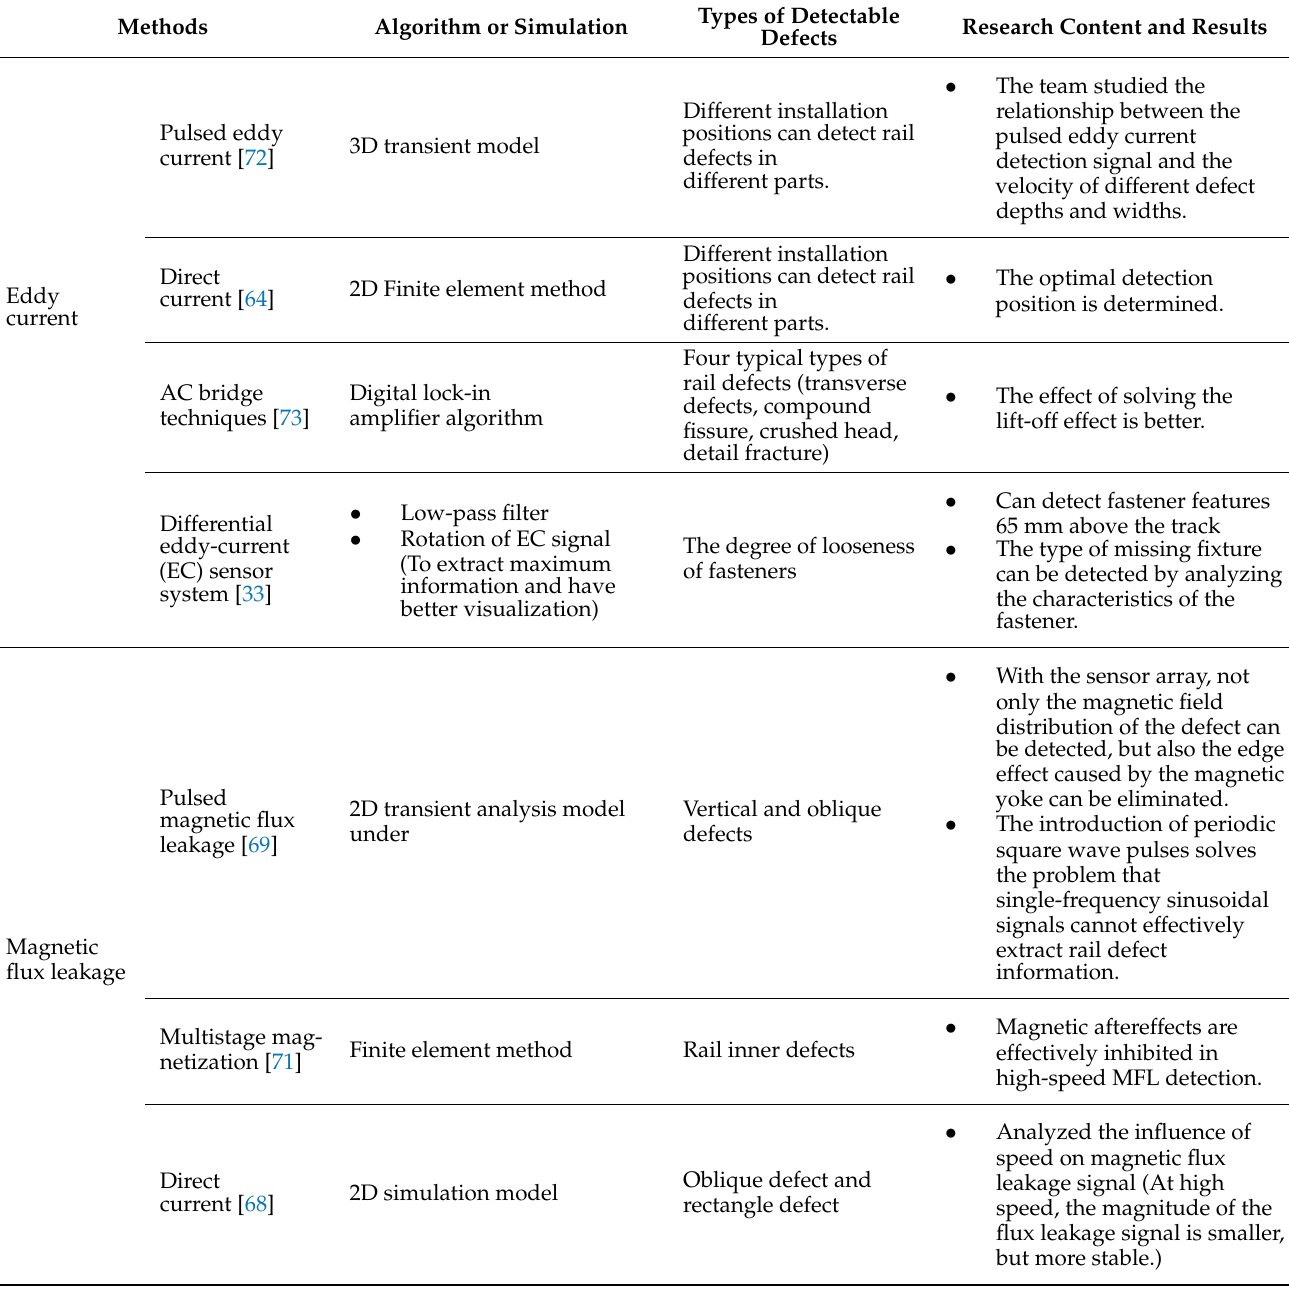
Table 4. Comparison of electromagnetic testing